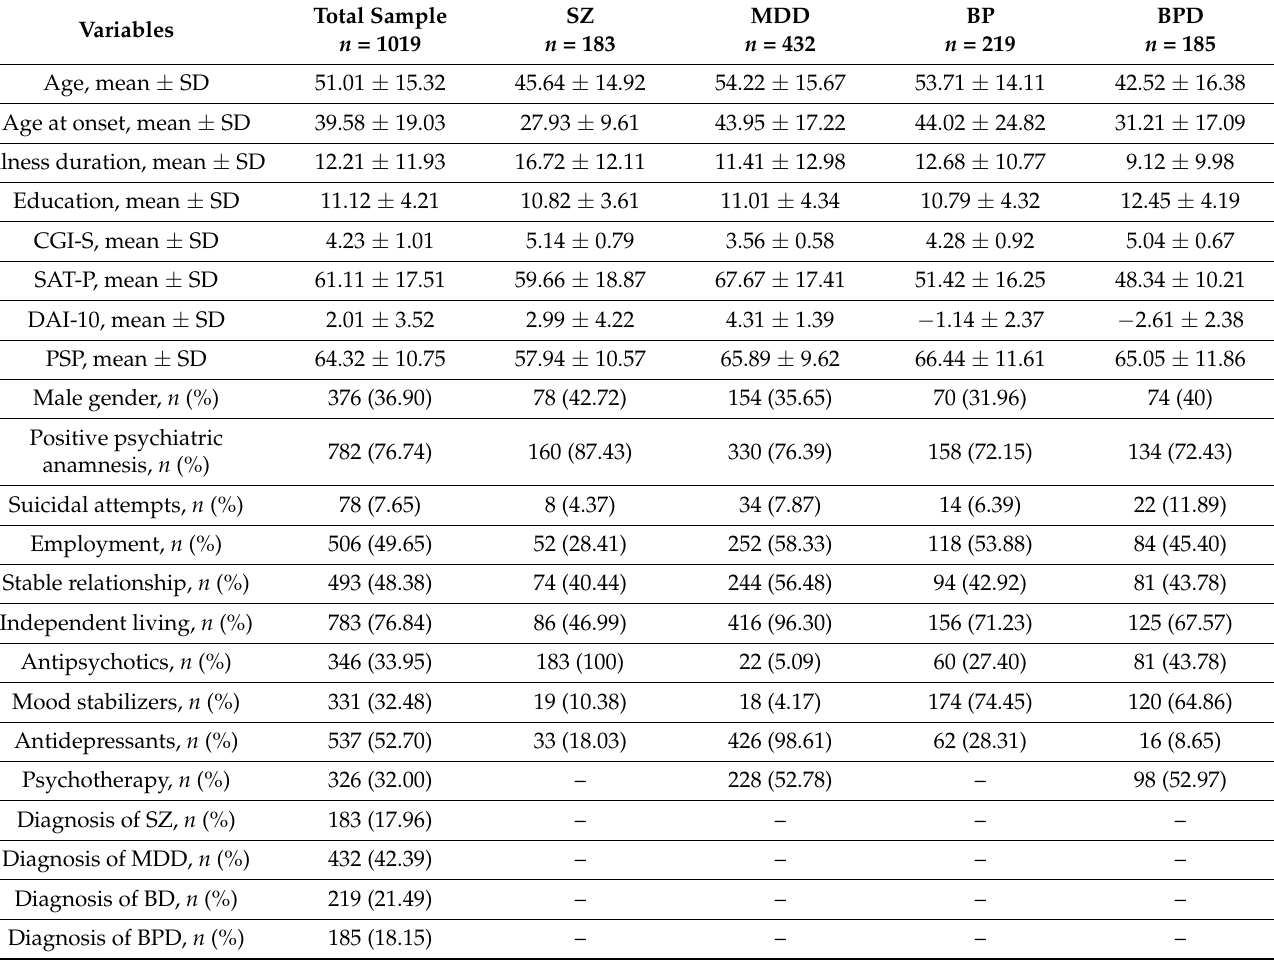
Table 1. Demographic and clinical variables in the total group of outpatients and in the subgroups: with a diagnosis of schizophrenia, or major depressive disorder, or bipolar disorder, and or borderline personality